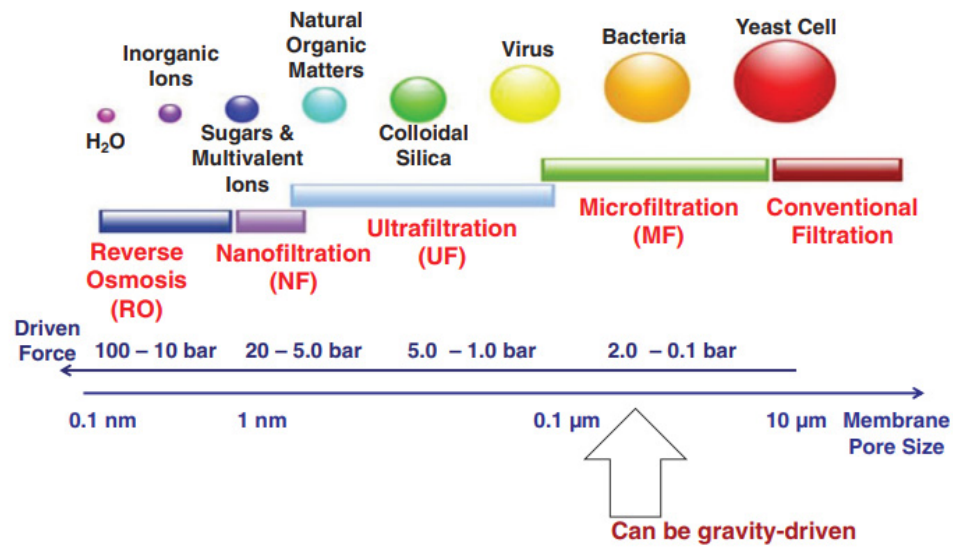
Figure 10. Pressure-driven membrane filtration classified according to pore size and pressure. Reprint from [157], Copyright 2020 with permission of John Wiley and Sons.